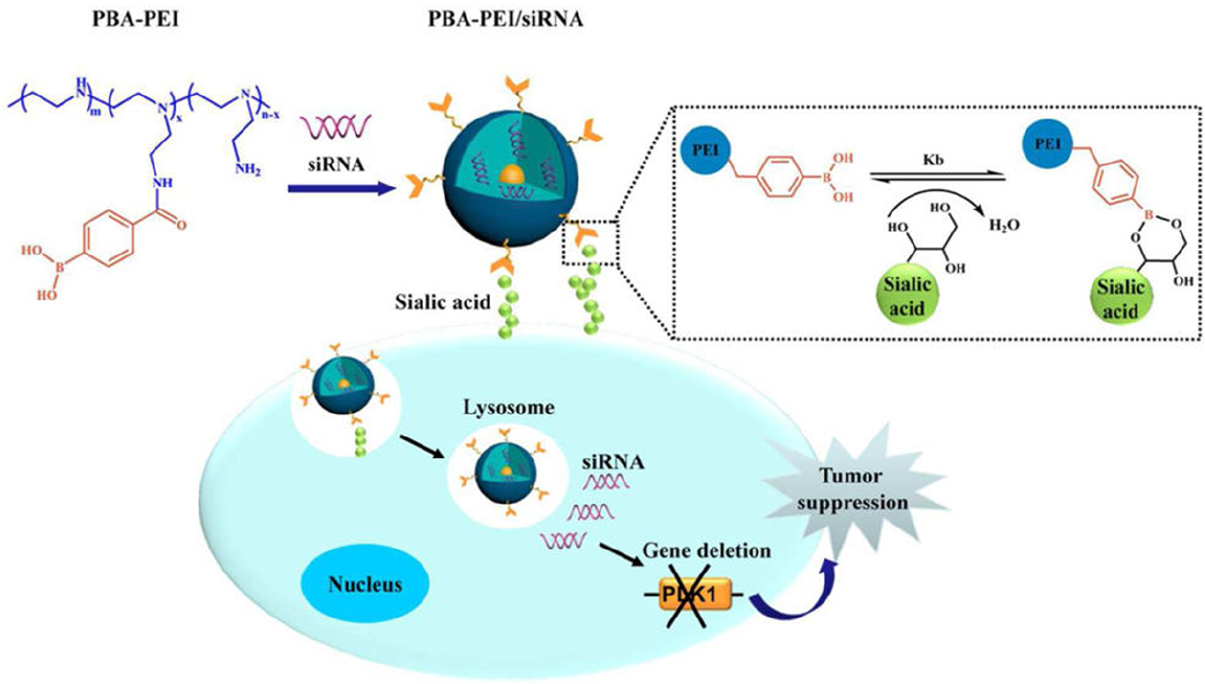
Figure 17: Synthesis of PEI-PBA conjugates for SA-targeted siRNA delivery. Reprinted with permission from [68]. Copyright 2016, American Chemical Society